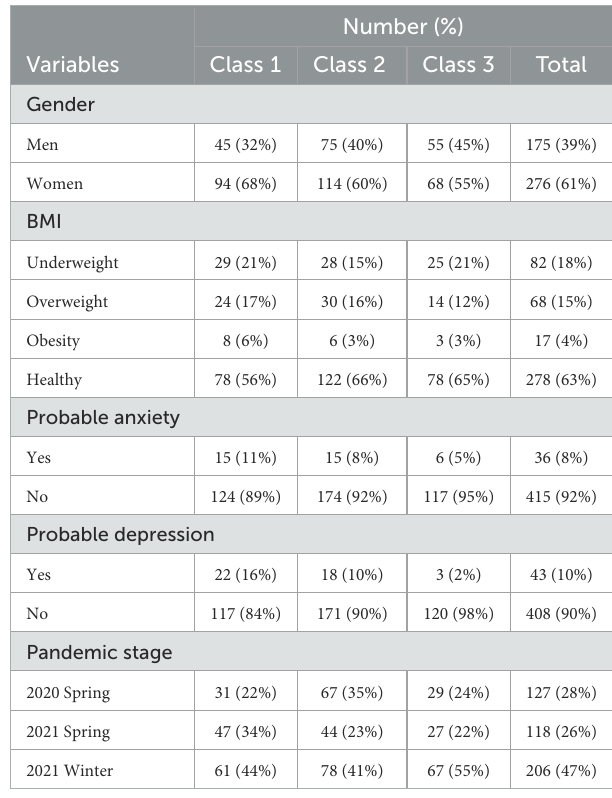
TABLE 4 Descriptive statistics of age, gender, BMI, probable anxiety, probable depression, and pandemic stage by